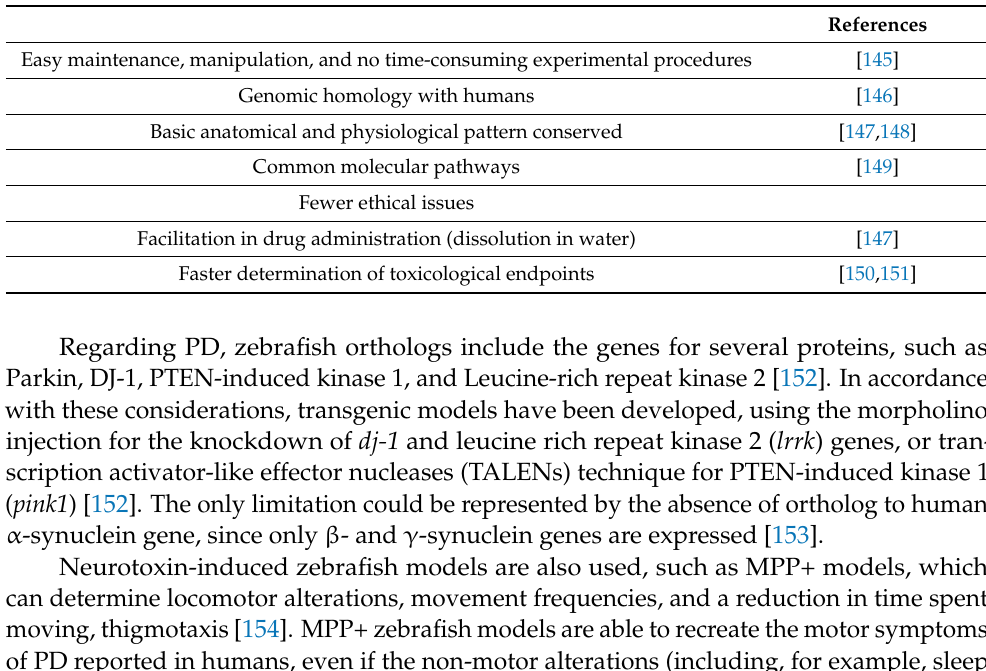
Table 1. Main advantages of using a zebrafish